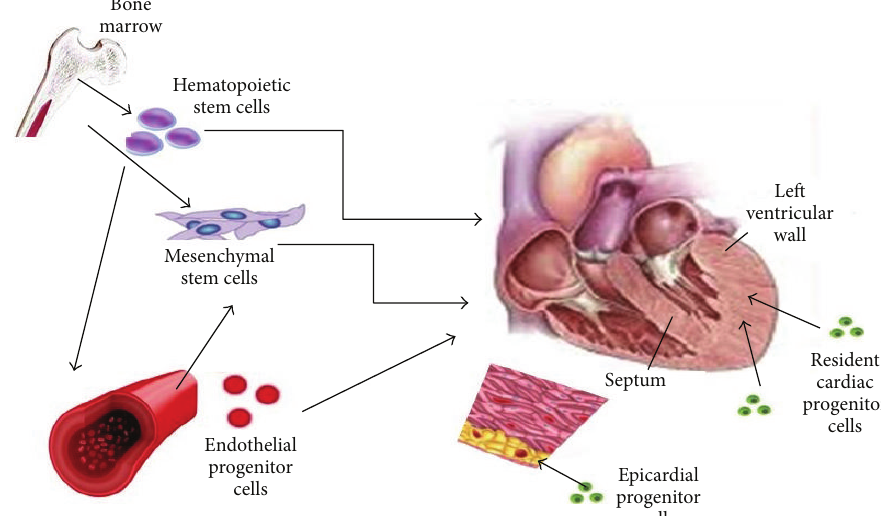
Figure 1: Sources of progenitor cells that participate in myocardial regeneration and remodeling in left ventricular hypertrophy.